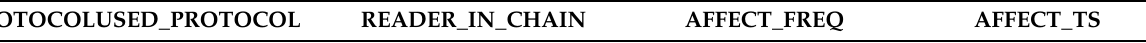
Table 3. Structure of the control memory table